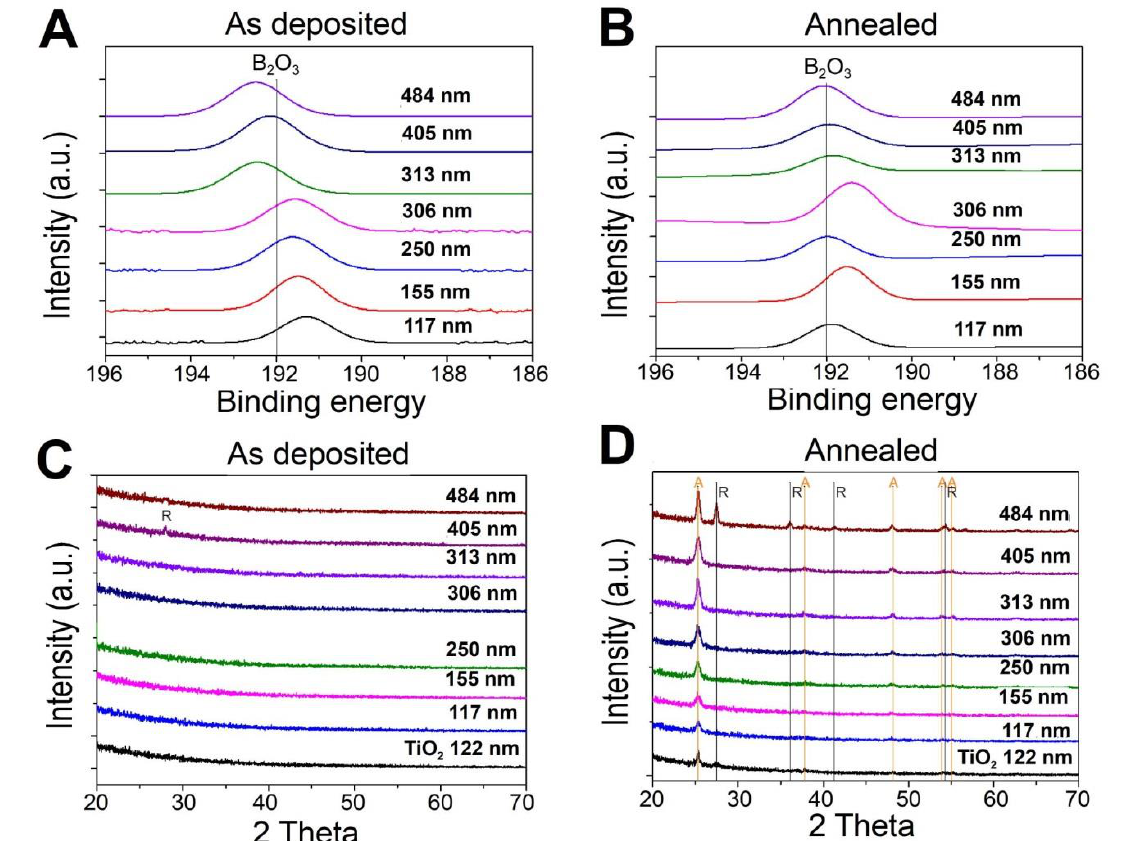
Figure 2. Boron contents in various TiO 2 (B) films. The XPS results of surface composition of the TiO 2 (B) films, ranging from 117 nm to 484 nm, before ( A ) and after ( B ) annealing. X-day diffraction analysis results obtained before ( C ) and after ( D ) annealing. TiO 2 122 nm are control groups with pure TiO 2 ( C , D ).